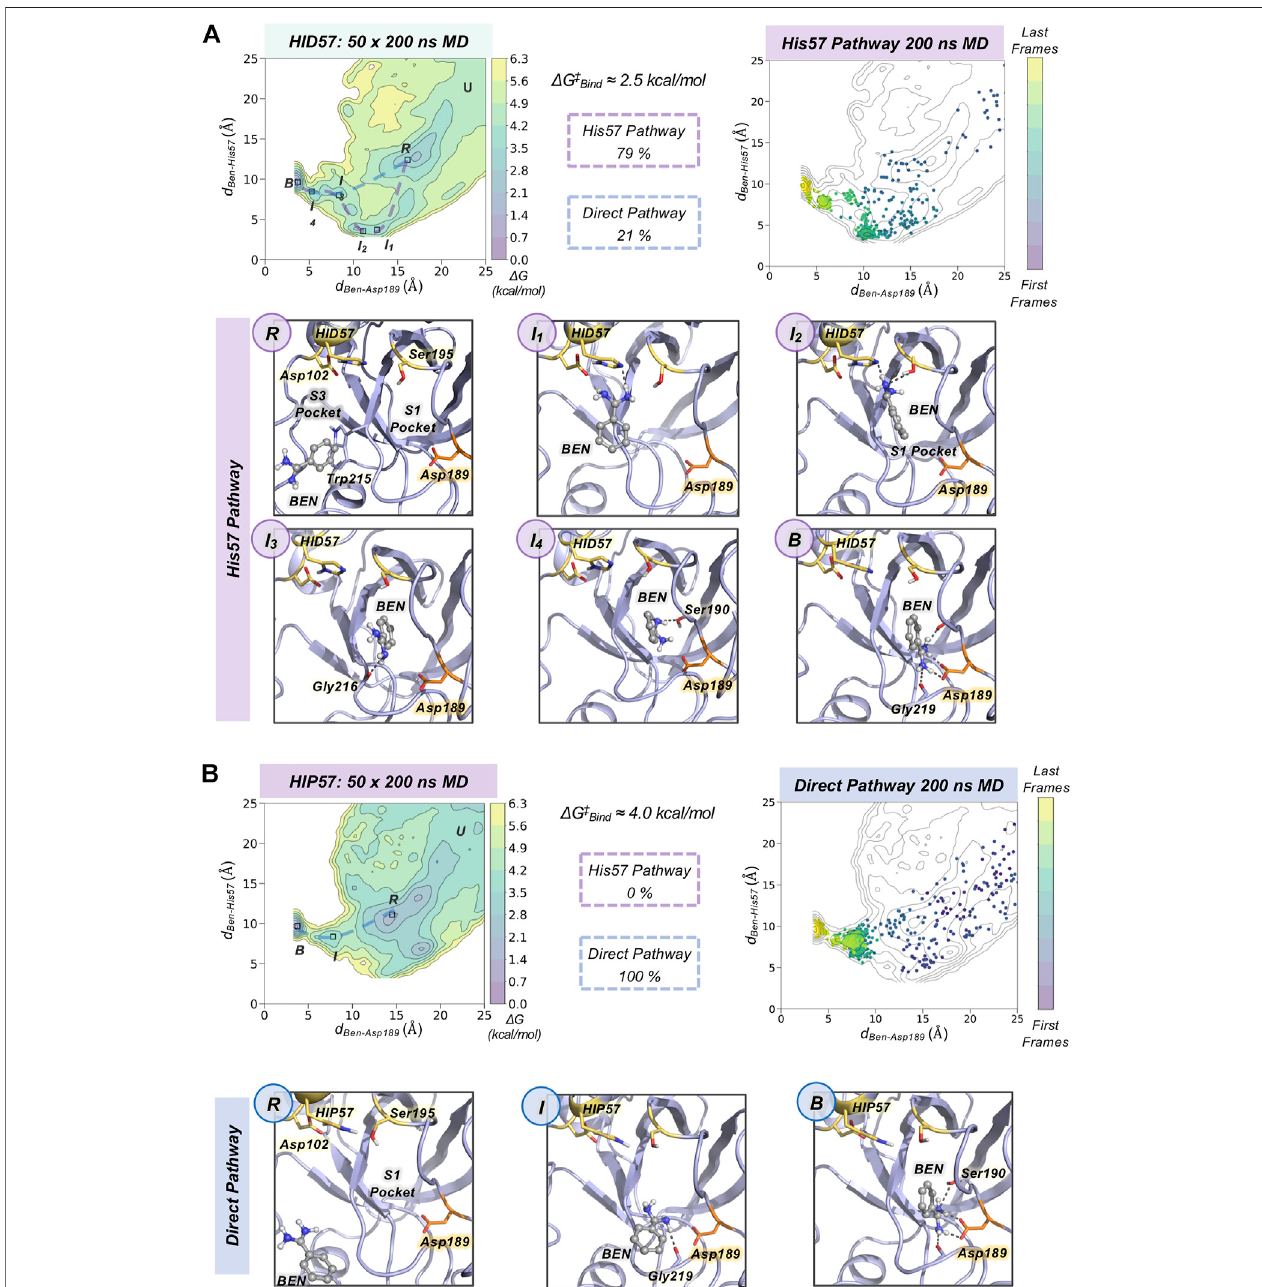
FIGURE3| Characterizationofbenzamidinebindingpathways.Freeenergylandscape(FEL)reconstructedfrom50replicasof200 nsofspontaneousbindingMD simulations ofHID57 (A) and HIP57 (B) using the binding distance ( d Ben-Asp189 , x axis) betweenthe carbon atom ofthe amidine group ofbenzamidine and thecarbon of the carboxylate group of Asp189 and the distance between the carbon atom of the amidine group of benzamidine and the epsilon nitrogen of His57 ( d Ben-His57 , y axis). The most relevant states of the FEL are highlighted in black boxes: U (unbound), R (recognition), B (bound) and I (intermediate) states. The free-energy difference between the unbound conformation and the transition state that leads to productive binding is given in kcal/mol. The purple dashed line indicates the trajectory of the His57 pathway while the blue dashed line indicates the trajectory of the direct pathway. The percentage of binding events (considering only productive binding simulations) that follow each pathway is provided. Projection of a representative spontaneous binding 200 ns MD trajectory on the FEL of each HID57 and HIP57. The time evolution of the ligand binding pathway is represented in a colour scale ranging from purple for the fi rst frames to yellow for the last frames of the MD trajectory. Molecular representation of the most relevant states of the FEL corresponding to the His57 and direct pathways. Catalytic residues are shown in yellow, benzamidine in grey, and Asp189 in orange.